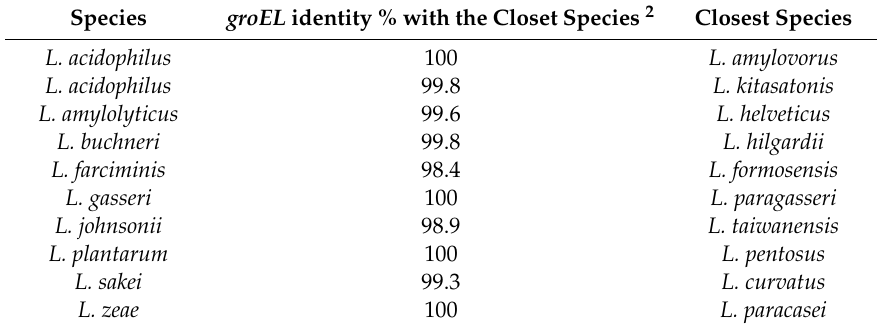
Table 3. Lactobacillus species with groEL sequence identity of over 97% with another Lactobacillus species. Species groEL identity % with the Closet Species 2 Closest Species L. acidophilus 100